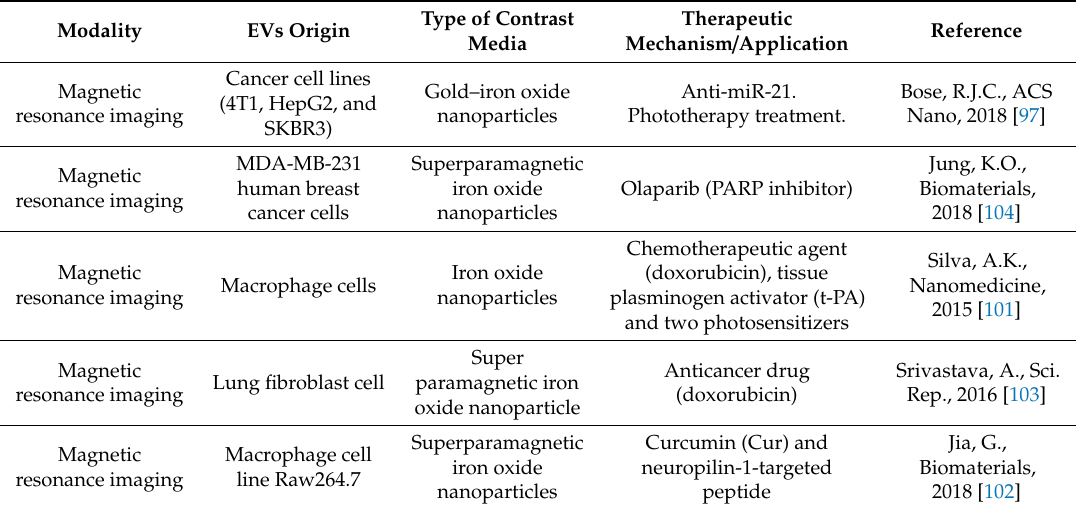
Table 4. Therapeutic and diagnostic application of EVs in a treatment